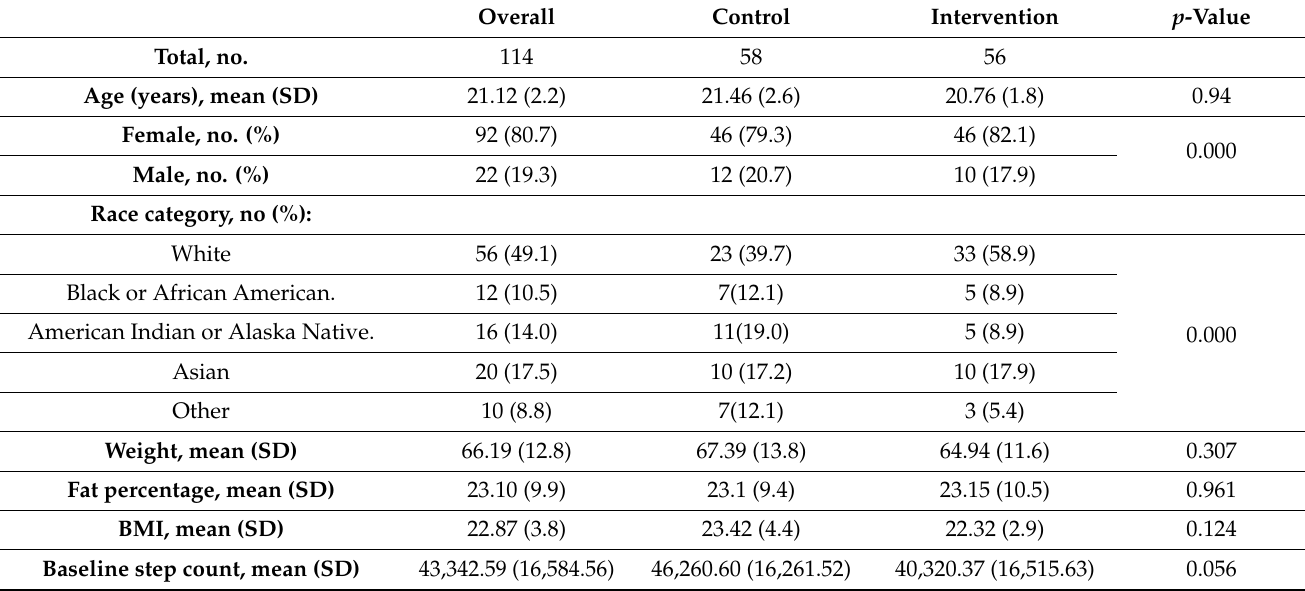
Table 1. Baseline characteristics of the participants according to the group allocation. Overall Control Intervention p -Value Total, no. 114 58